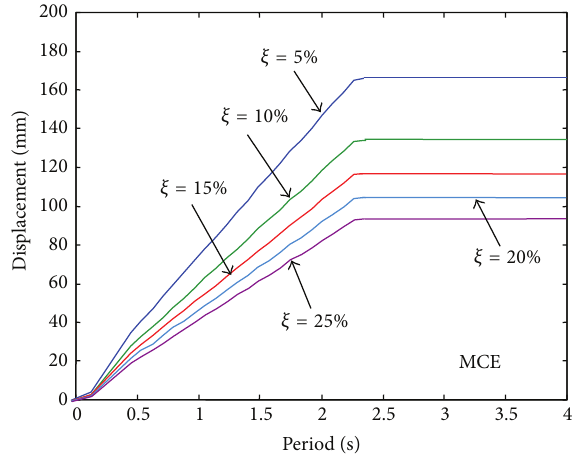
Figure 6: Normative displacement elastic response spectrum for Sesto Fiorentino—MCE level, 𝜉 = 5 %, 10%, 15%, 20%, and 25%, = 50 years, coefficient of use 𝑐 𝑉 n and C-type